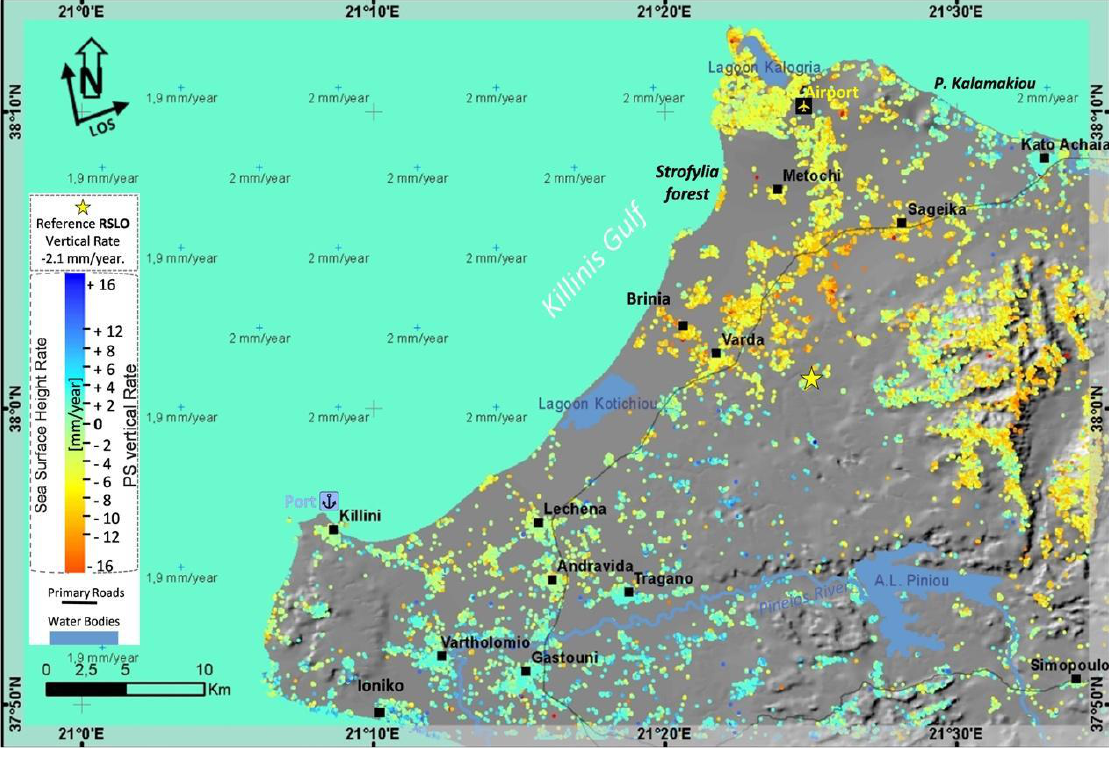
Table 5. Statistics of the sub-areas of the Killini,Araxos. Amongst others the characteristic (mean) values of vertical deformation rate, the relative sea level rise and the uncertainty are shown. PS stands for permanent scatterers; GNSS for Global Navigation Satellite System; RSL for relative sea level Mean Location of PSs